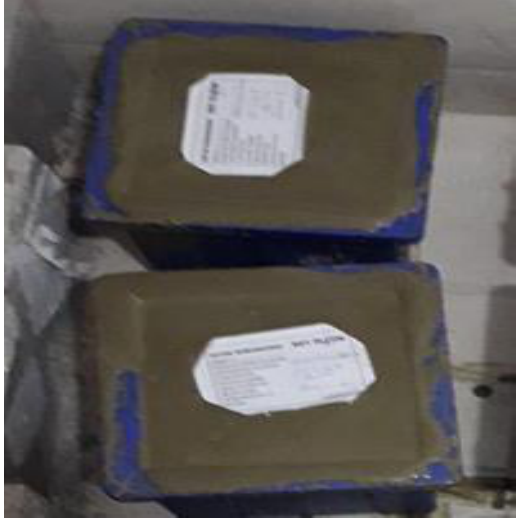
Figure 5. Binder reference mortar for optimum binder fixation.